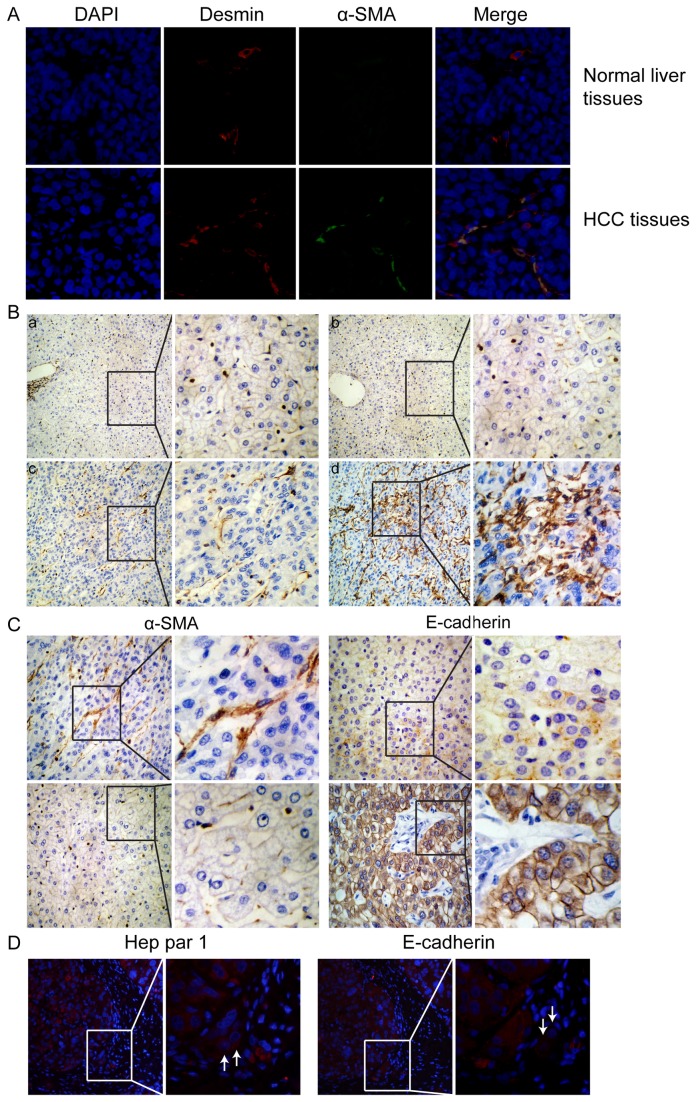
tHSCs are associated with E-cadherin expression, HCC cell invasion in human HCC specimens, and poor survival outcome.(A) Representative immunostaining of HSCs in normal liver tissues and HCC tissues with α-SMA and desmin antibodies. (B) Representative samples of the tHSC density determined by α-SMA immunostaining (magnification, ×200). Typical grades 0, 1, 2, and 3 are shown in a, b, c, and d, respectively. (C) Representative pictures of α-SMA and E-cadherin expressions in human HCC tissues detected by immunostaining (magnification, ×400). tHSC-rich is accompanied by deccreased E-cadherin expression in case 1 (upper panel), and tHSC-poor is accompanied by increase E-cadherin expression in case 2 (lower panel). (D) Immunofluorescence staining separately with Hep Par 1 and E-cadherin antibody on serial sections of one HCC sample (magnification, ×400). The white arrows indicated the tumor cells with both Hep Par 1-positive and E-cadherin-negative staining that have infiltrated from their nests into the surrounding stroma. (E) The impact of tHSCs on the survival of HCC patients. (a) tHSC-associated overall survival rate. (b) tHSC-associated recurrence-free survival rate.